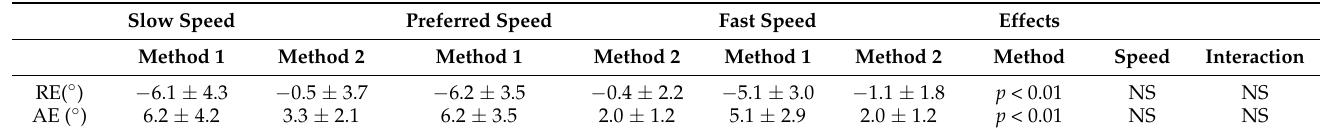
Table 1. Means and standard deviations (SD) of relative errors (RE) and absolute errors (AE) obtained for each force-plate method in the three speed conditions. NS: non-significant difference ( p >